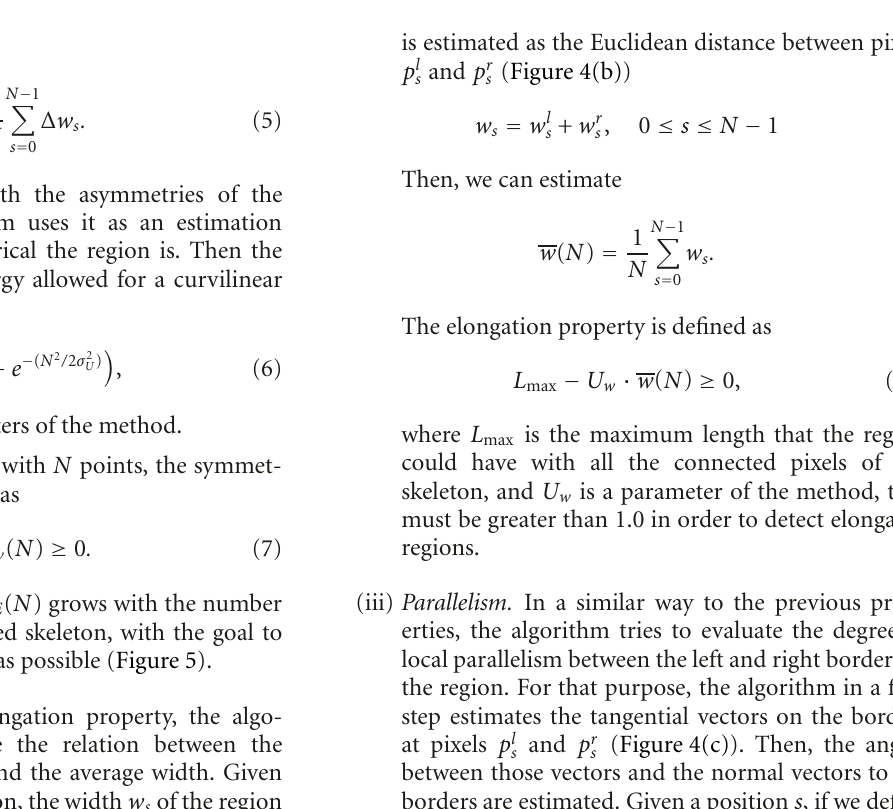
and w r are s s and p r are s s